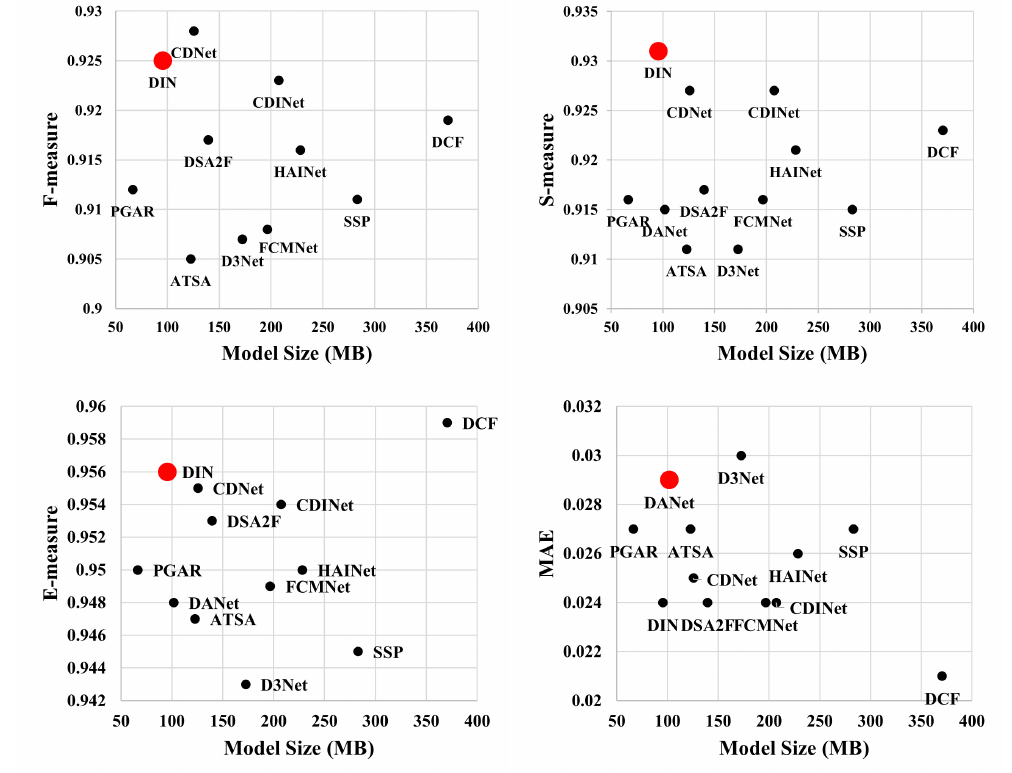
Figure 4. Scatter diagrams of model size and performance (F-measure, S-measure, E-measure, and MAE) on the NLPR dataset. The DIN achieves state-of-the-art performance with fewer